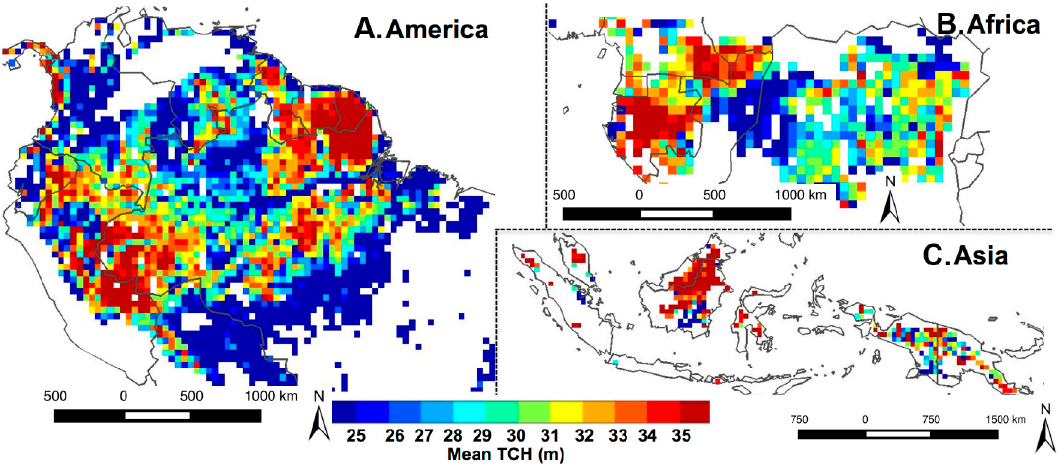
Figure 1. TCH m calculated from GLAS dataset in 0.5-deg resolution. ( A ) TCH m of South America; ( B ) TCH m of Central Africa; and ( C ) TCH m of Southeast Asia. Pixels were colored white and marked invalid if there are less than 50 GLAS points available in each pixel.